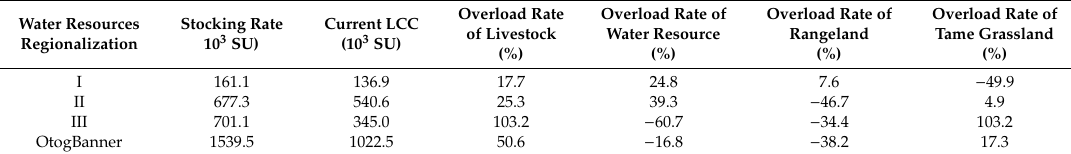
Table 7. Analysis of stocking capacity balance based on dynamic